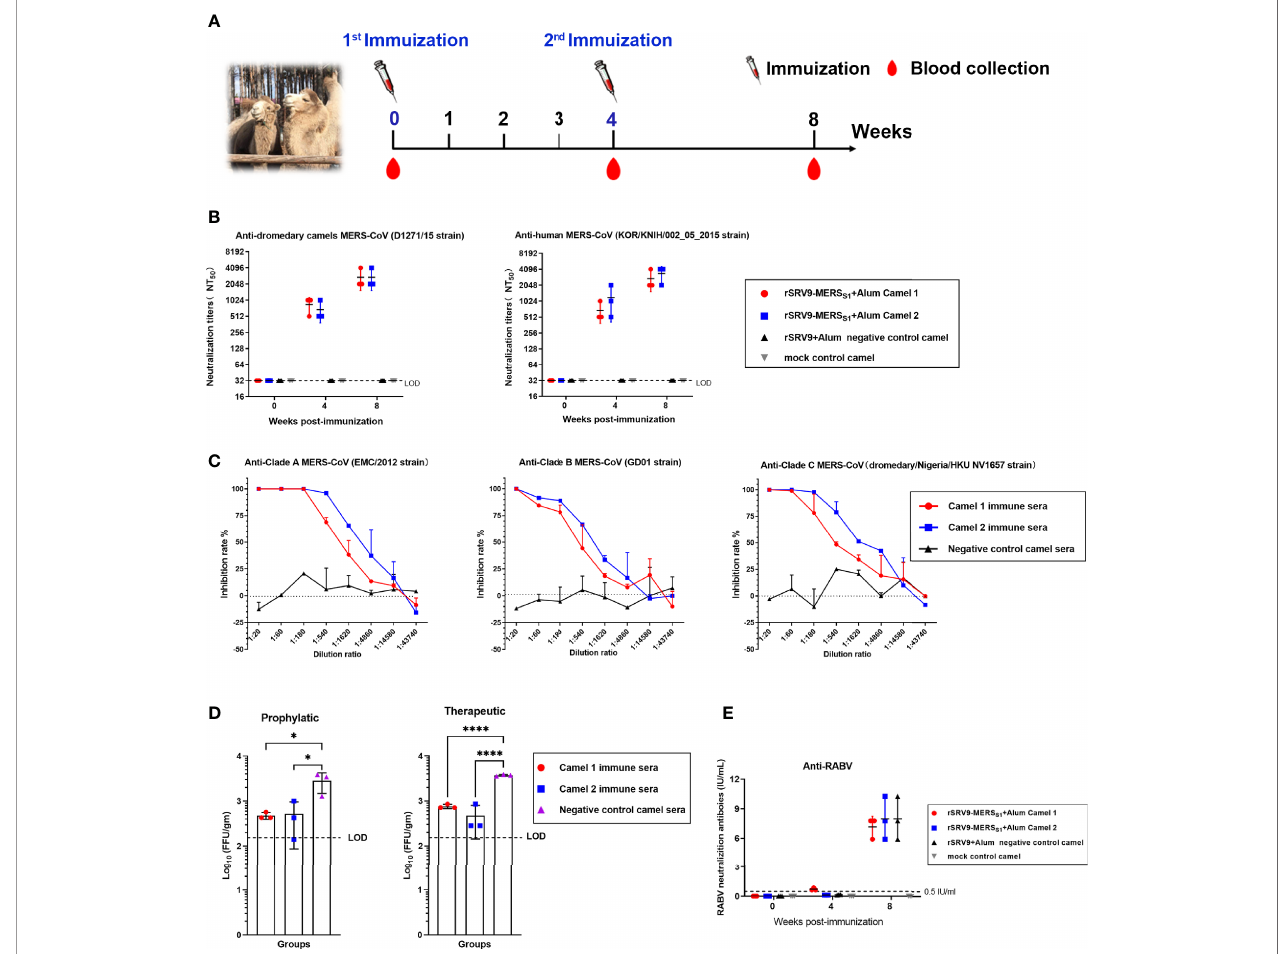
FIGURE 5 | Humoral immune responses elicited by the inactivated rabies virus-vectored MERS-CoV vaccine in camels. (A) The schematic of the camel immunization experiment. Four Bactrian camels were injected subcutaneously (s.c.) in the neck with 5 ml of inactivated recombinant rabies virus-vectored MERS-CoV vaccine (n = 2) or the inactivated parental rabies virus vaccine (n = 1) or phosphate-buffered saline (PBS) (n = 1) two times at 4-week intervals. Sera of camels from each group were harvested before the fi rst immunization and collected at weeks 4 and 8 after the fi rst immunization. (B) Sera cross-neutralizing activity against representative human and camel MERS-CoV strains (human MERS-CoV KOR/HIN strain and dromedary camel MERS-CoV D1271 strain) were evaluated by a pseudovirus- based neutralization assay. (C) The cross-neutralizing activity against live viruses among the known MERS-CoV clade A (EMC/2012 strain), clade B (ChinaGD01 strain), and clade C (dromedary/Nigeria/HKU NV1657 strain) were measured by plaque reduction neutralizing assay. (D) Prophylactic and therapeutic ef fi cacies of passive transfer with the rabies virus-vectored MERS-CoV vaccine camel immune sera collected at 8 w.p.i in MERS-CoV-infected Ad5-hDPP4-transduced mice (n = 3 per group). A total of 200 m l of camel immune sera collected was intravenously transferred 1 day before or after MERS-CoV (EMC/2012 strain) infection. Mice in the control group (n = 3) intravenously received the same dose of negative sera from healthy camels at the same time points. (E) The RABV-speci fi c neutralizing antibody titers of sera from each group of mice (n = 3) were evaluated using fl uorescent antibody virus neutralization (FAVN). Data are shown as mean ± SD. Data were obtained using GraphPad Prism version 9.0 (GraphPad software). Signi fi cance was calculated using a one-way ANOVA with multiple comparisons tests (not indicated in graph; *p < 0.05, ****p <